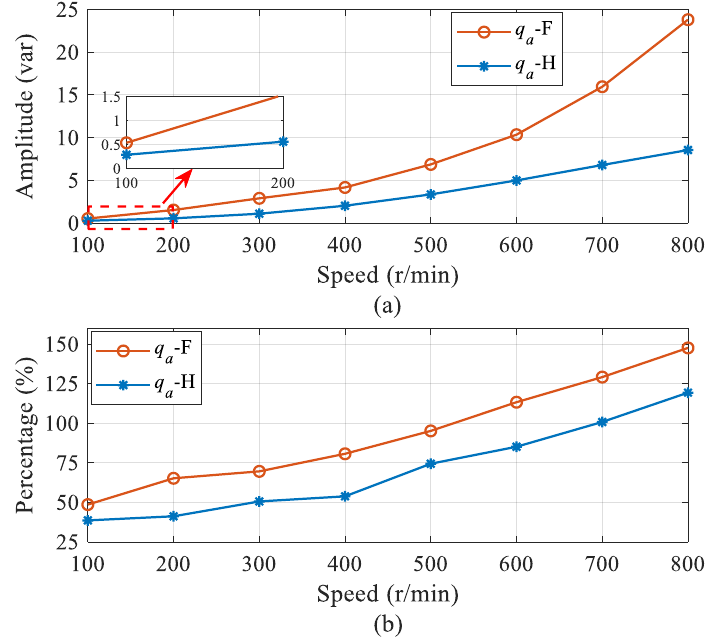
Figure 12. The amplitudes of the second harmonics in IRPs ( a ) and the proposed indicators ( b ), with ITSC, at different speeds. T L was fixed at 3 N∙m.